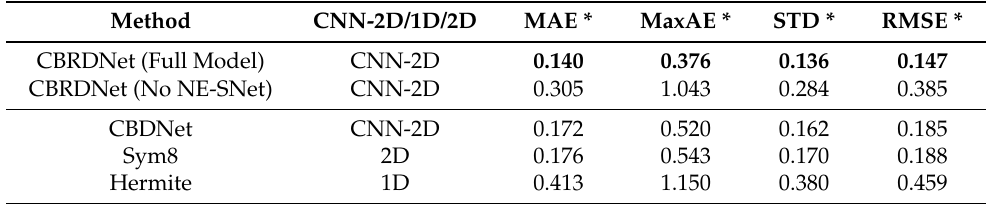
Figure 15. Results of the proposed NE-SNet subnetwork estimating the noise level map over a set of real and synthetic data samples. Noisy Sample stands for the corrupted noisy data, groundtruth is the known noise level map, finally NE-SNet is the estimated noise output. Color scale values are expressed in millimeters (mm). (Color online). Table 3. Comparative results of our NE-SNet subnetwork ablation study with the full model and the best CNN and conventional denoising approaches. MAE = mean absolute error; MaxAE = maximum absolute error; STD = standard deviation of the absolute error; RMSE = root mean squared error. Best results presented in bold